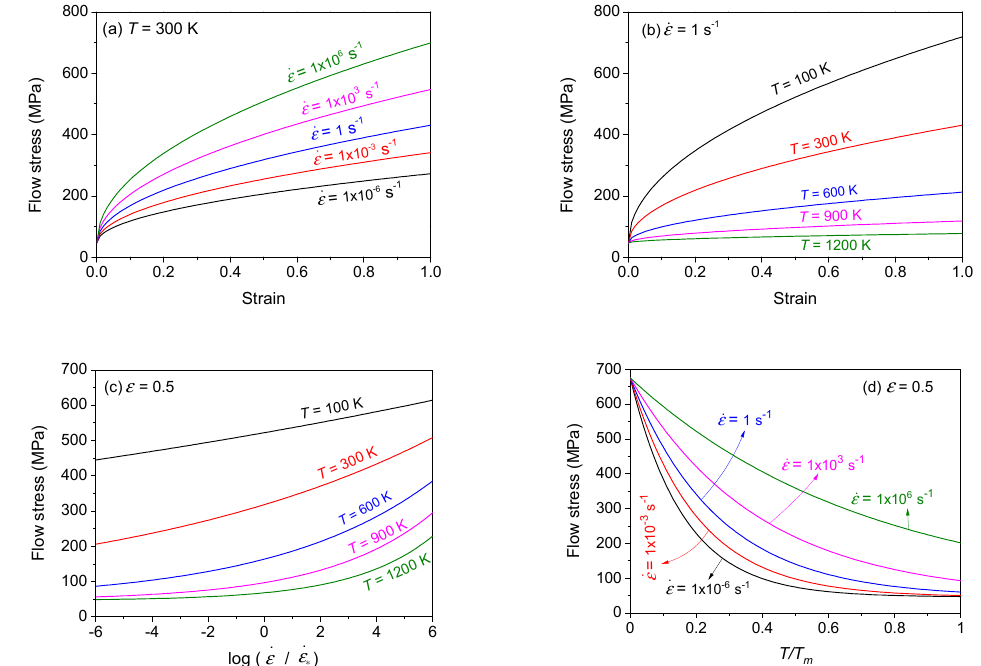
Figure 16. Flow stress–strain curves predicted for copper (FCC) using the ZA model ( a ) at 300 K for different strain rates and ( b ) at 𝜀(cid:4662) = 1 for different temperatures. Change in flow stress at 𝜀 = 0.5 ( c ) with log ( 𝜀(cid:4662) / 𝜀(cid:4662) ∗ ) for different temperatures and ( d ) with T / T m for different strain rates ( 𝜀(cid:4662) ∗ = 1 s − 1 , T m = 1356 K).